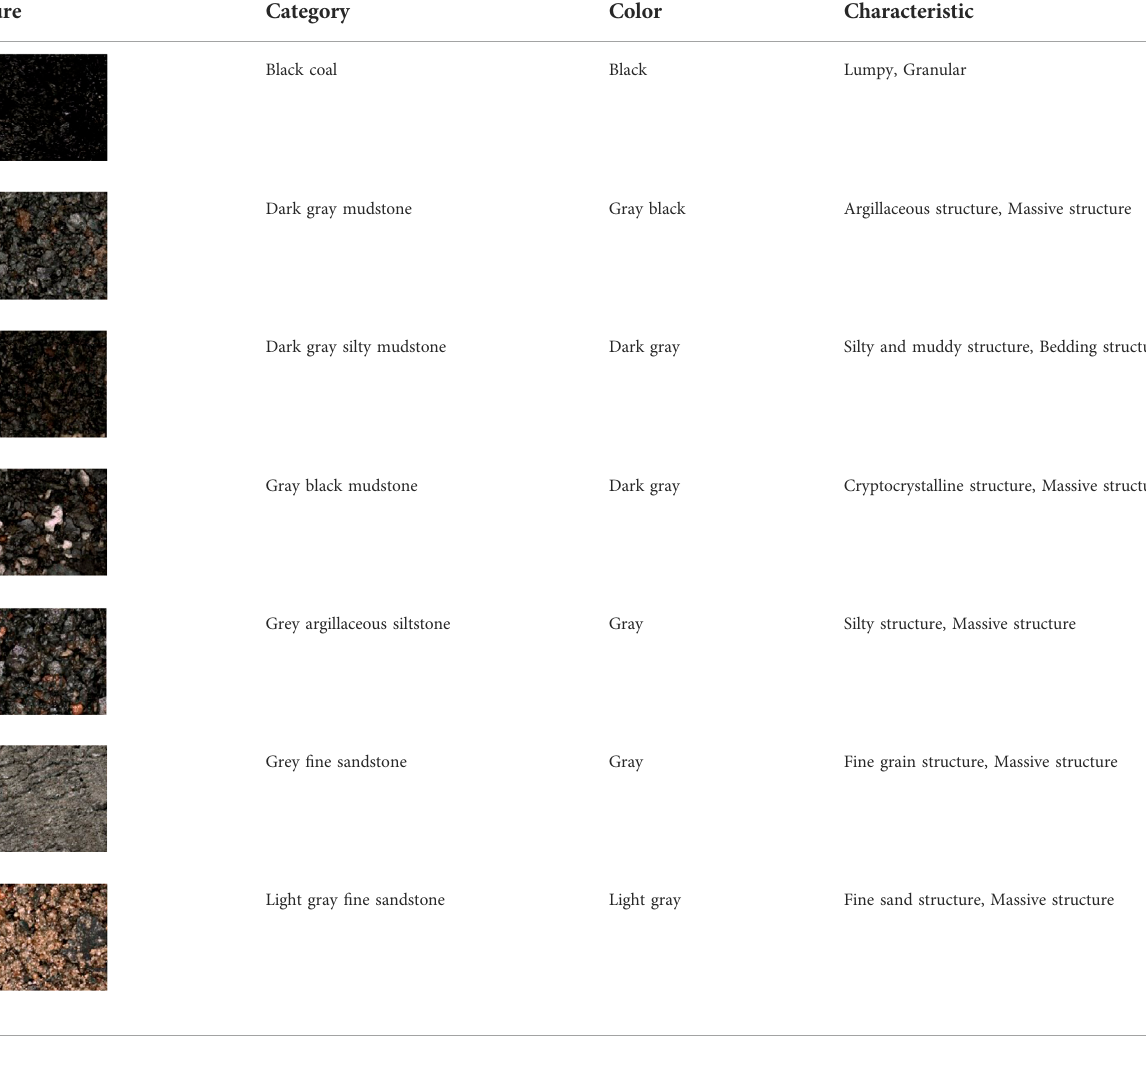
TABLE 1 The characteristics of seven types of rocks.